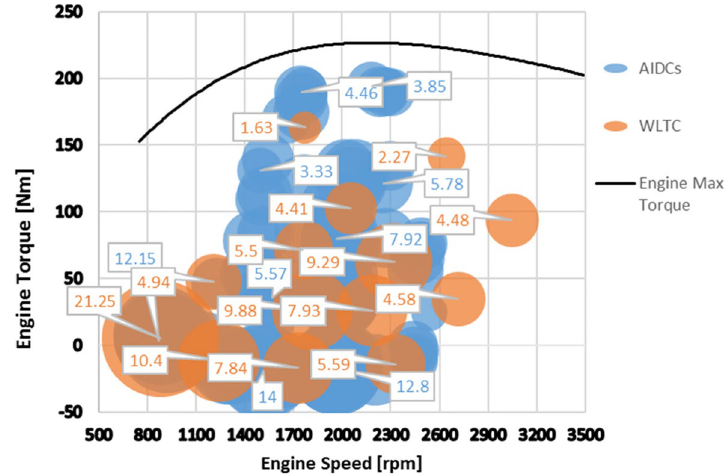
Fig. 8 Engine operating conditions at AIDCs and WLTC cycles